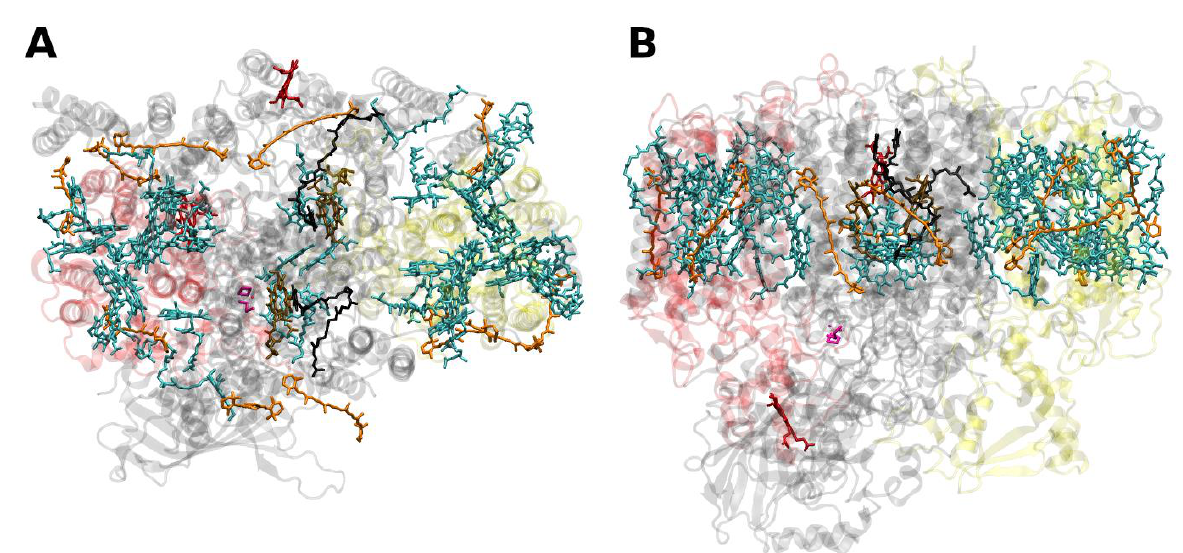
Figure 4. Structure of the photosystem II core with the core-antenna complexes CP43 and CP47 from the thermophilic cyanobacterium Thermosynecchococcus vulcanus at 1.9 Å resolution, PDB entry 3ARC [57]. ( A ) Top view with regard to the thylakoid membrane plane, seen from the stromal side. ( B ) Side view with regard to the thylakoid membrane plane. The protein backbone of CP43 (CP47) is shown in red (yellow); other protein subunits are shown in grey. Chlorophylls a are shown in cyan, β-carotenes in orange, pheophytin in brown, heme groups in dark red and benzoquinones in grey. The oxygen–manganese cluster of the water splitting apparatus is also shown (violet).